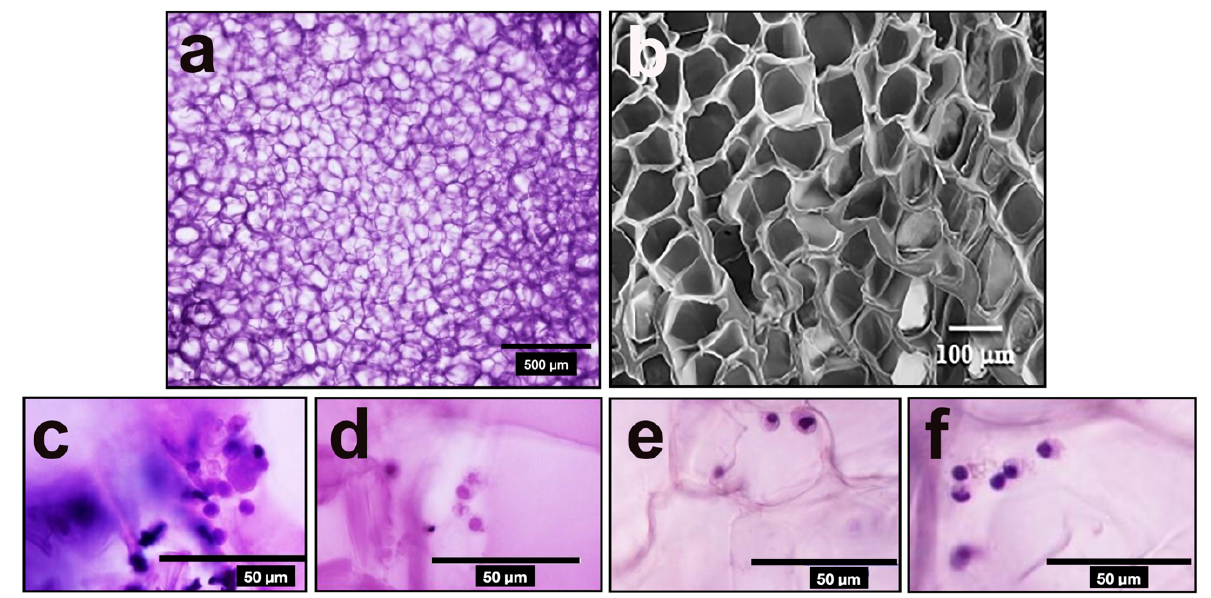
Figure 2. Morphology of Ge/HA scaffolds intertwined with EDC: ( a ) paraffin section of a scaffold without cells stained with H-E. ( b ) SEM of Ge/HA without cells; ( c , d ) paraffin sections of total spleen cell culture on Ge/HA scaffolds stained with H-E; ( e , f ) paraffin sections of splenic DC cultured on Ge/HA scaffolds stained with H-E. In ( a , b ), it can be seen that the scaffolds are porous and that they are interconnected. Furthermore, in ( c , d ), it can be seen that the DC are closely adhered to the trabeculae of the Ge/HA scaffolds.